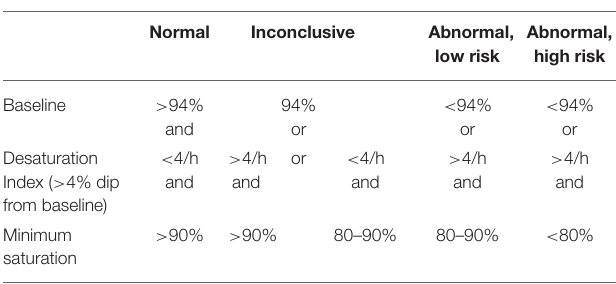
TABLE 1 | Oximetry risk criteria for